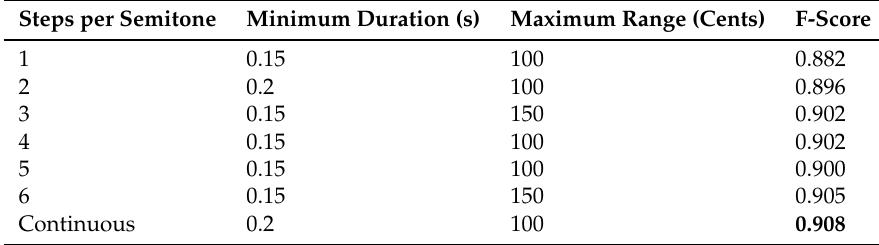
Table 3. Best result of each semitone step division level.